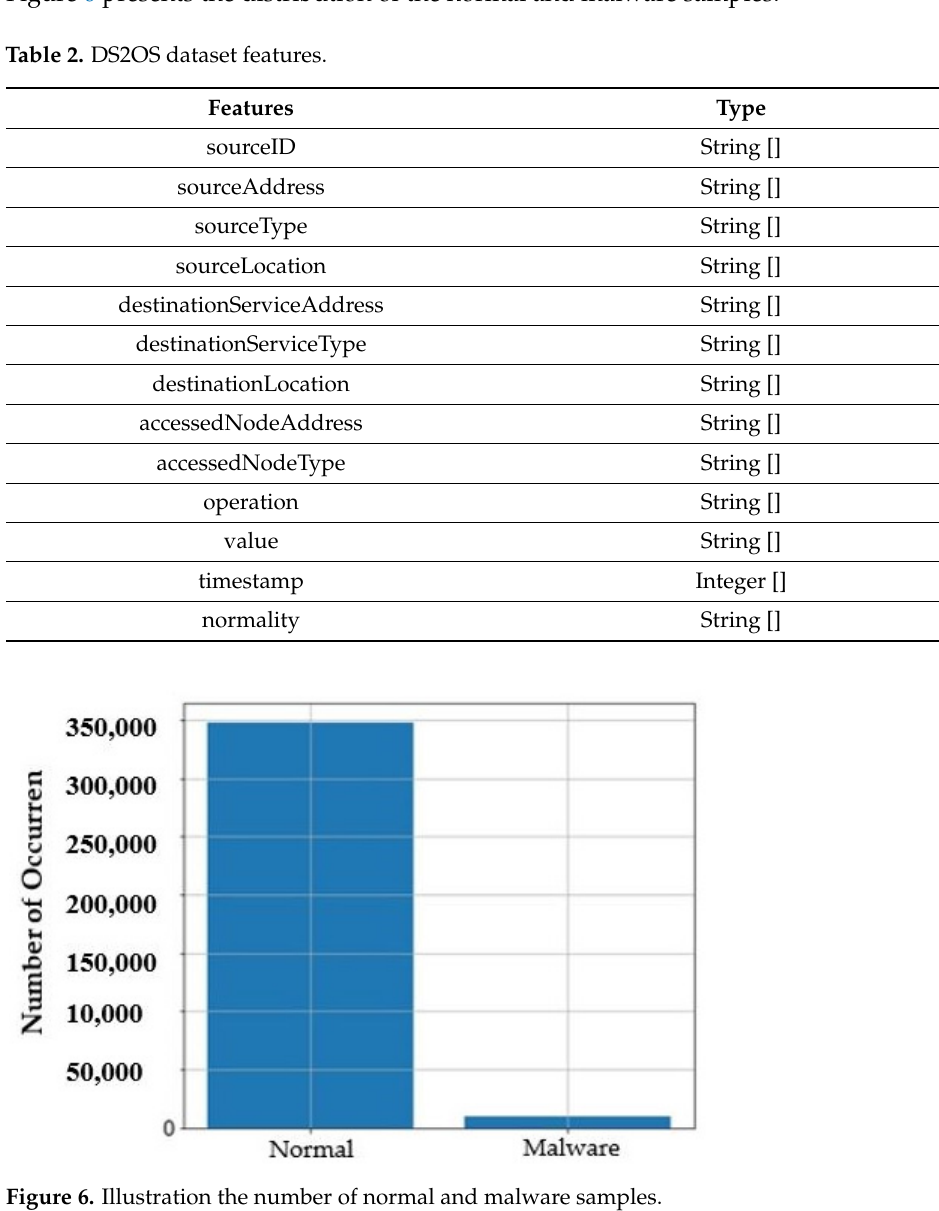
Figure 6. Illustration the number of normal and malware samples. Table 2. DS2OS dataset features.